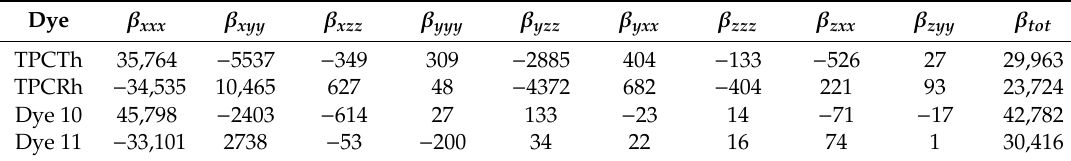
Table 5. Hyperpolarizabilities of TPCTh, TPCRh, Dye 10 and